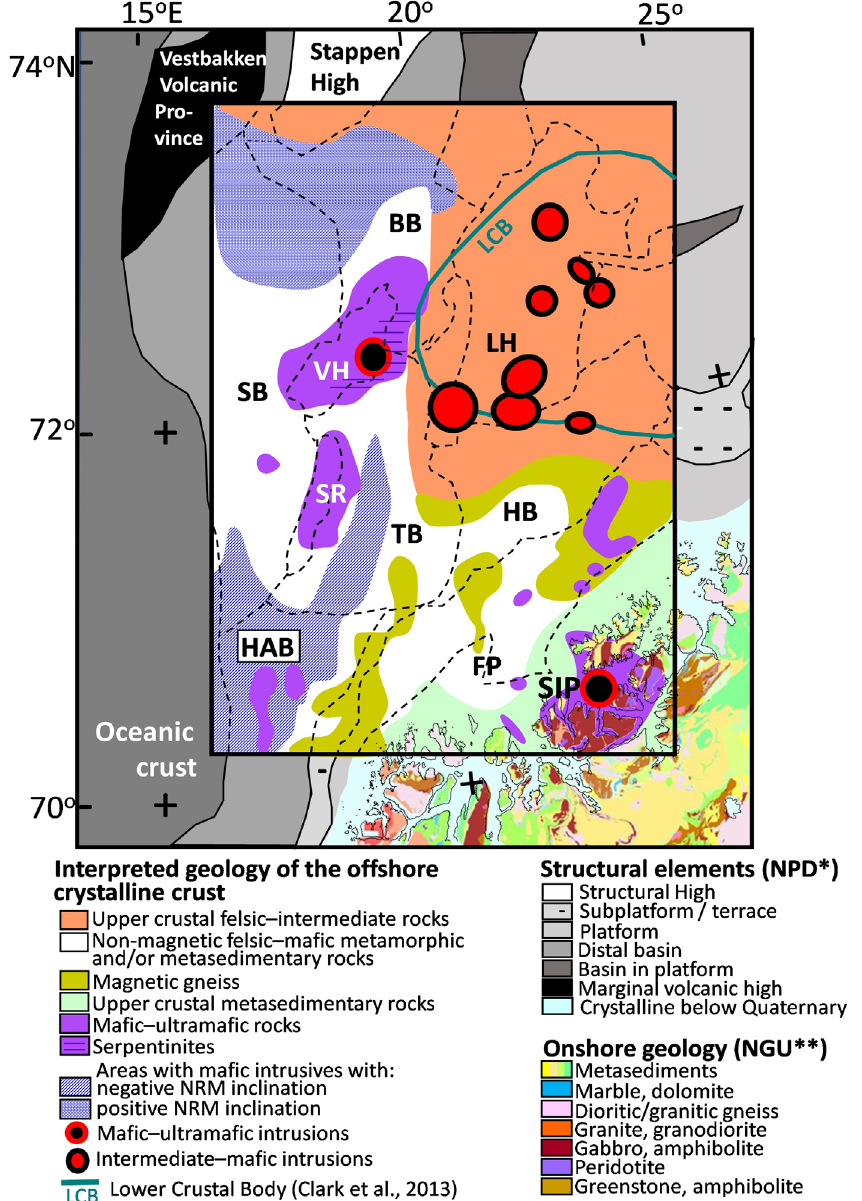
Figure 14. Interpretation results of this study compiled in a new map showing the offshore geology of the crystalline crust. *Structural elements, and boundaries of structural elements at base Cretaceous level (black dashed; Norwegian Petroleum Directorate: www.factmaps.npd.no/factmaps/3_0/ visited 11.01.2022, based on Gabrielsen et al., 1984; 1990), abbreviations see Fig. 2). **Onshore geological map (Geological Survey of Norway: www.ngu.no/emne/kart- pa-nett “Berggrunn 1:250,000 vektor (Gammel)” visited 11.01.2022). NRM – Natural Remanent